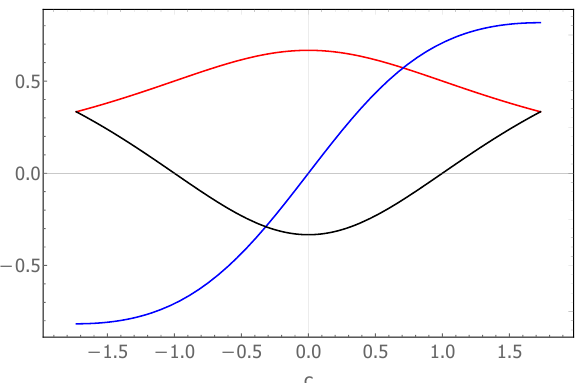
Figure 1 . The Kasner exponents p t (black line), p x (red line) and p φ (blue line) as functions of parameter c in